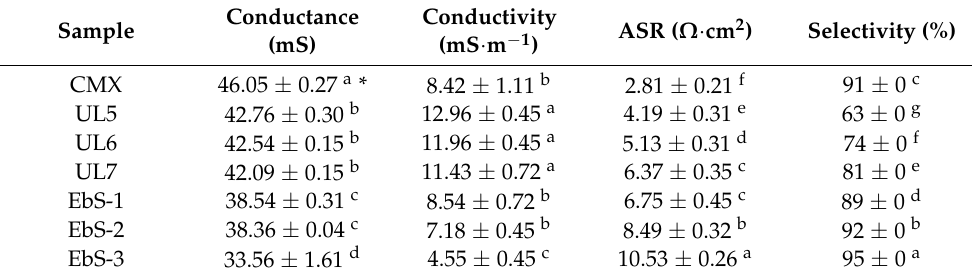
Table 3. Conductance, conductivity, ASR, and selectivity of hCEMs and CMX.